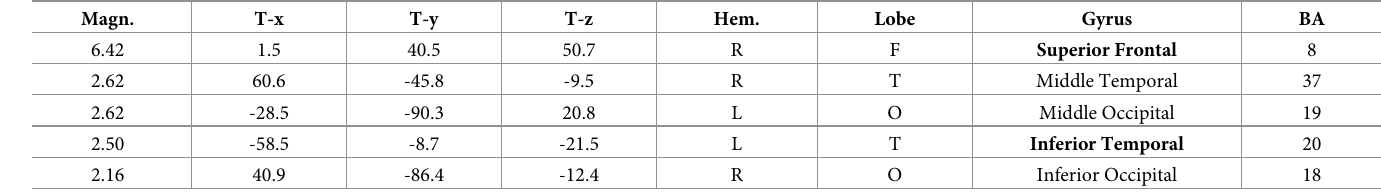
The table provides Talairach coordinates and localization of the active electromagnetic dipoles explaining the surface difference-voltage (incongruent–congruent) recorded in the 350–550 ms time window, according to swLORETA inverse solution. Magn. = Magnitude; Hem = Hemisphere; BA = Brodmann areas; T = Talairach; R = right; L = left.